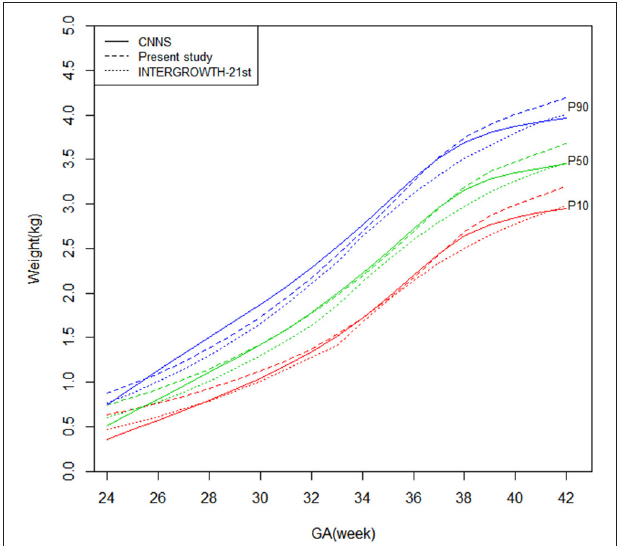
FIGURE 4 | Comparison of birthweight (kg) curves by gestational age between the present study and Fenton curve